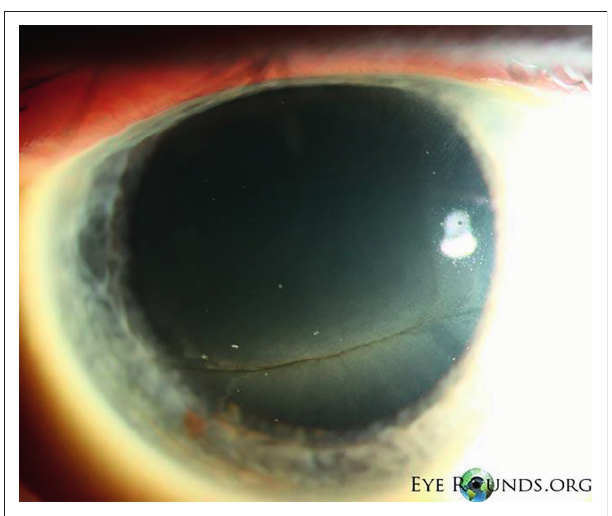
FIGURE 1: Verticillata resulting from Fabry’s disease.